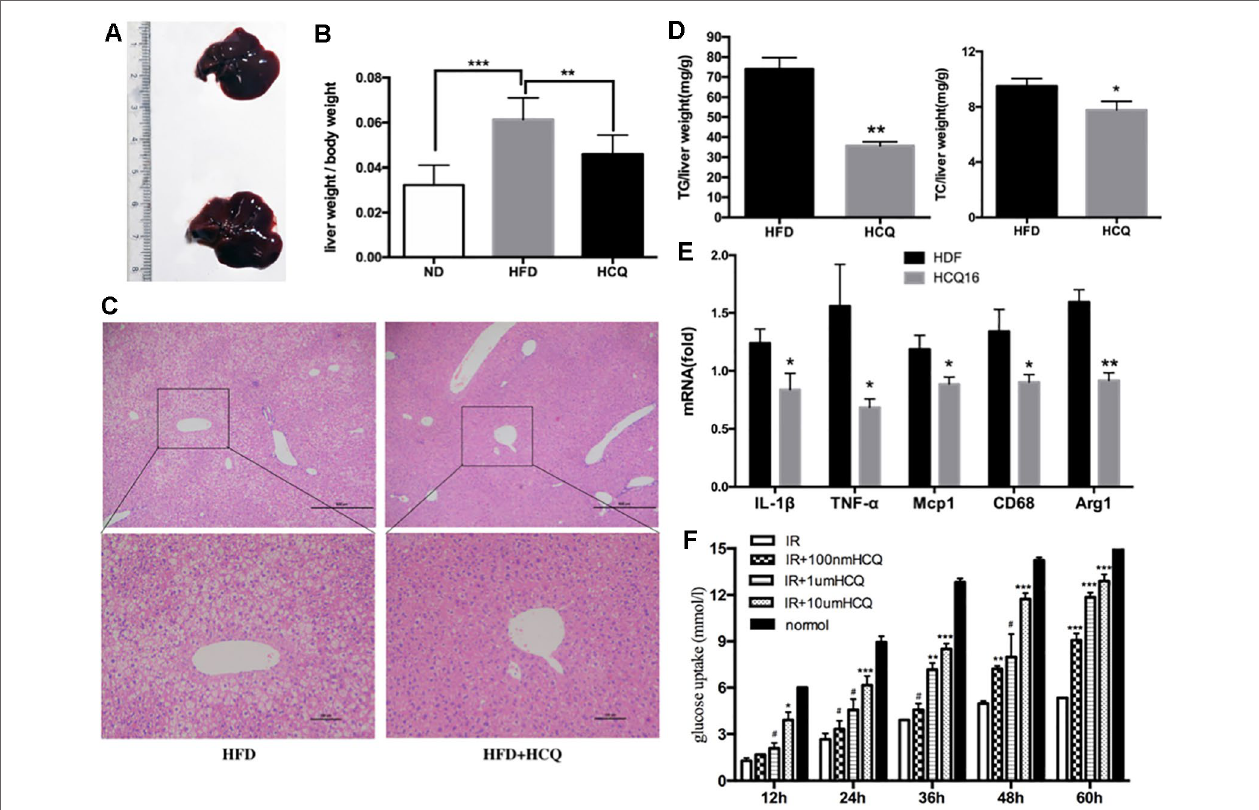
FIGURE 4 | HCQ improved HFD-induced hepaticectopic lipid accumulation. (A) Liver tissues were extracted from HFD mice and HFD mice treated with HCQ. (B) The liver weight per body weight. Liver section paraffin-embedded samples were analyzed for histopathological changes after staining with hematoxylin–eosin. (C) Scale bar = 200 μ m and 100 μ m. (D) The levels of triglyceride (TG, n = 8) and total cholesterol (TC, n = 6) measured in the liver of mice treated with vehicle or HCQ for 16 weeks. (E) The mRNA levels of pro-inflammatory cytokines in hepatic tissue were analyzed by real-time PCR. (F) The glucose uptake in HepG2 cells incubated by 0.1, 1.0, and 10.0 μ M of HCQ for 12, 24, 36, 48, and 60 h. The values were presented mean ± standard error of the mean (SEM). The error bars represent the SEM. The significant differences compared with vehicle controls were indicated by * P < 0.05 and ** P < 0.01 (assessed by Student’s t